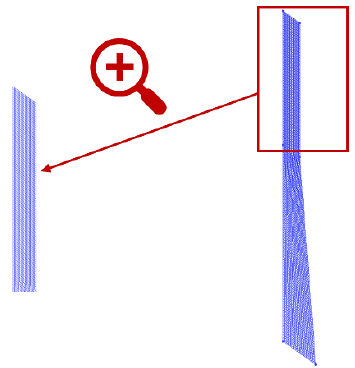
Figure 1. Schematic diagram of Mesh 2.